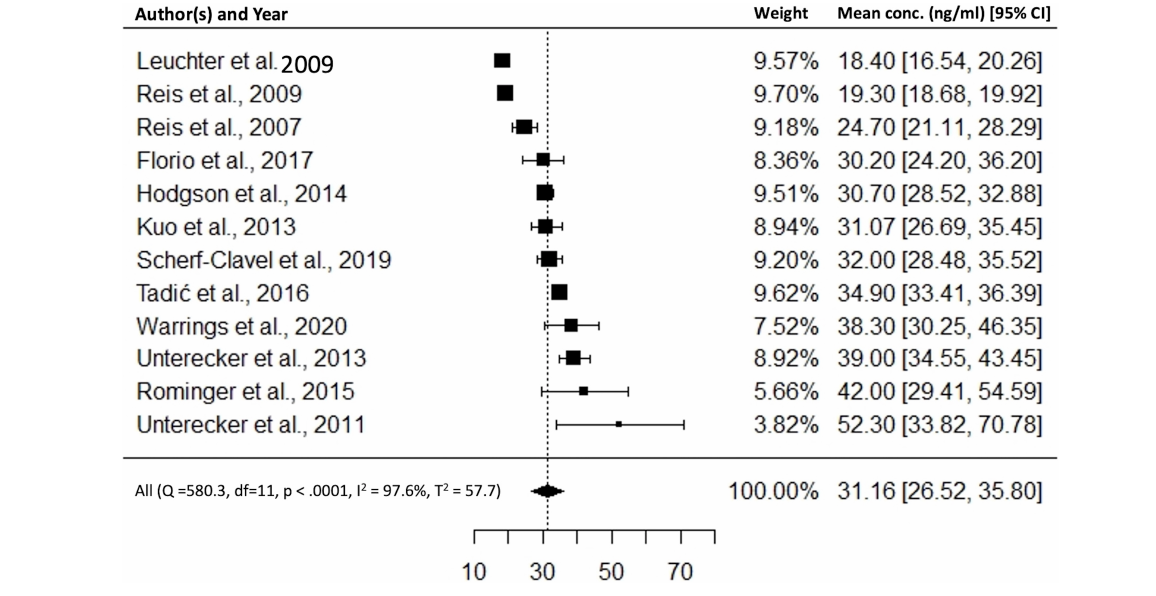
FIGURE2 Combined mean ESC concentrations, n = 5,031.